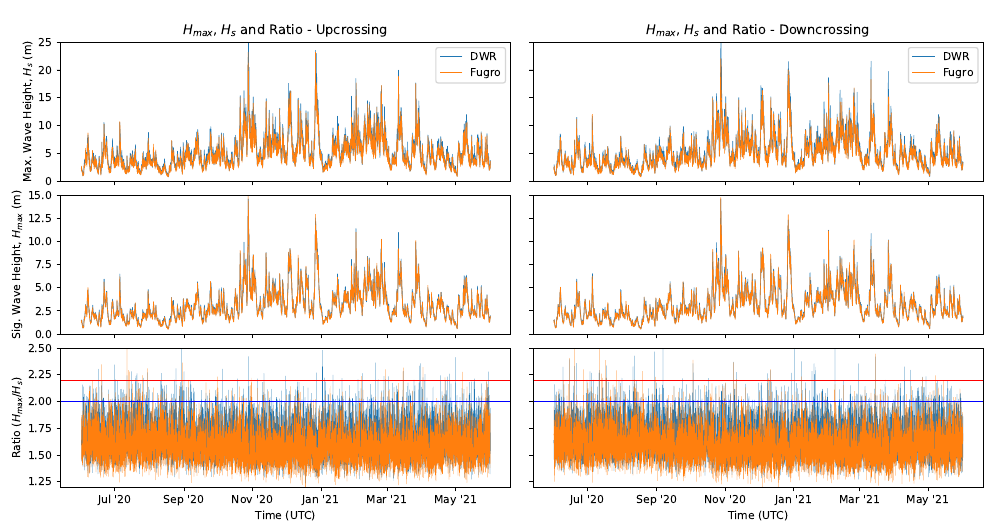
Figure 6. H max , H s and the ratio H max / H s for the two observation systems over the buoy deployment period (June 2020 to June 2021). The analysis compares the up-crossing ( left ) and down-crossing ( right )